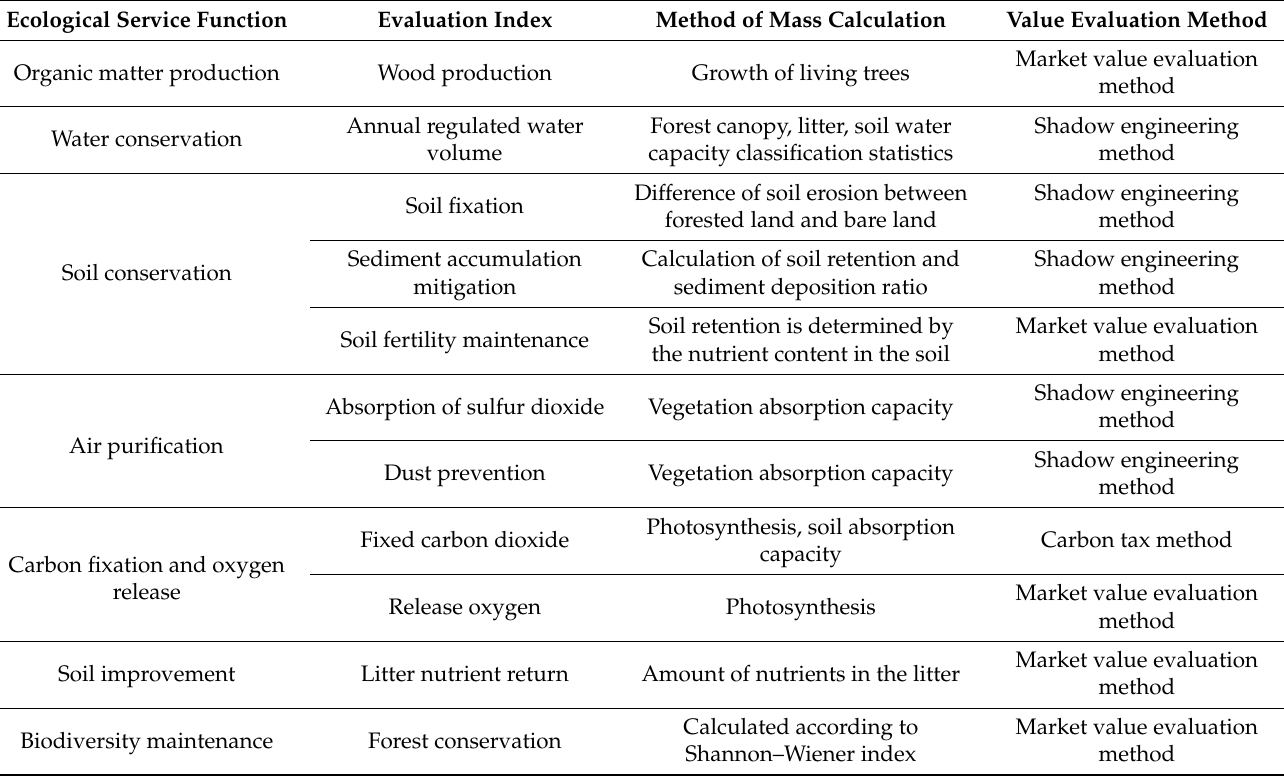
Table 2. Evaluation indexes and methods of main ecosystem services of Liquidambar formosana